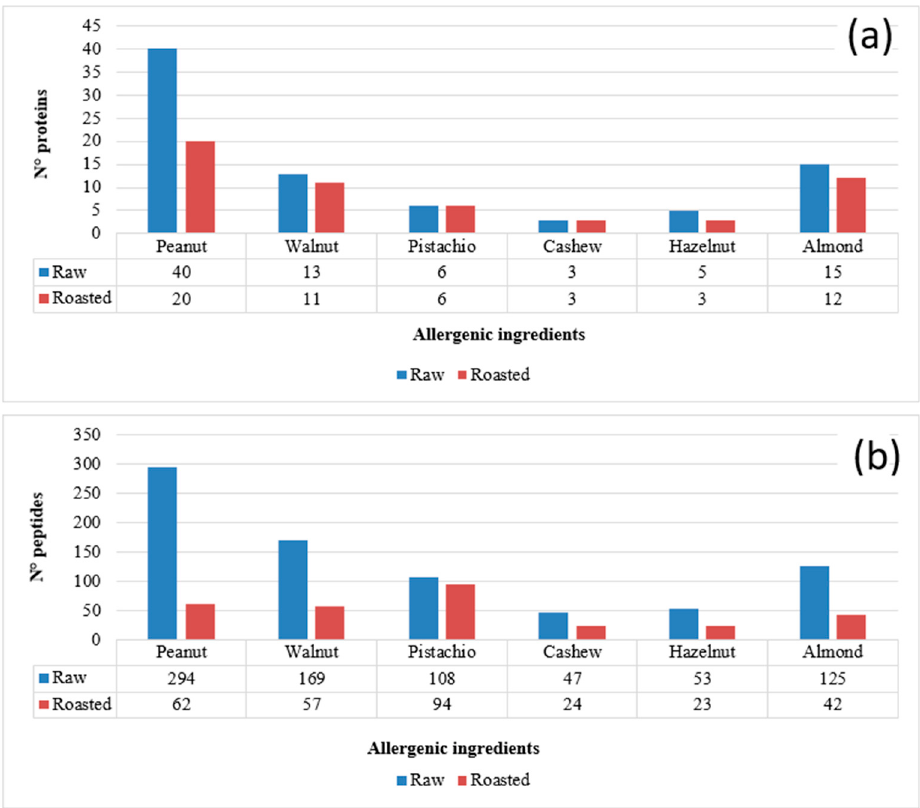
Figure 1. Numbers of proteins ( a ) and peptides ( b ) identified after the LC-ESI-MS and MS/MS analysis of the tryptic digests of protein extracts obtained from the five tree nuts and peanuts under study, considered as raw or roasted product. Protein identification was based on the Proteome Discoverer™ software operating on tryptic peptide MS/MS spectra obtained through Data Dependent™ MS/MS acquisitions and against a customized food allergen database. Bioinformatic filters used: (i) number of peptides recognized for each protein ≥ 2; (ii) Sequest HT score ≥